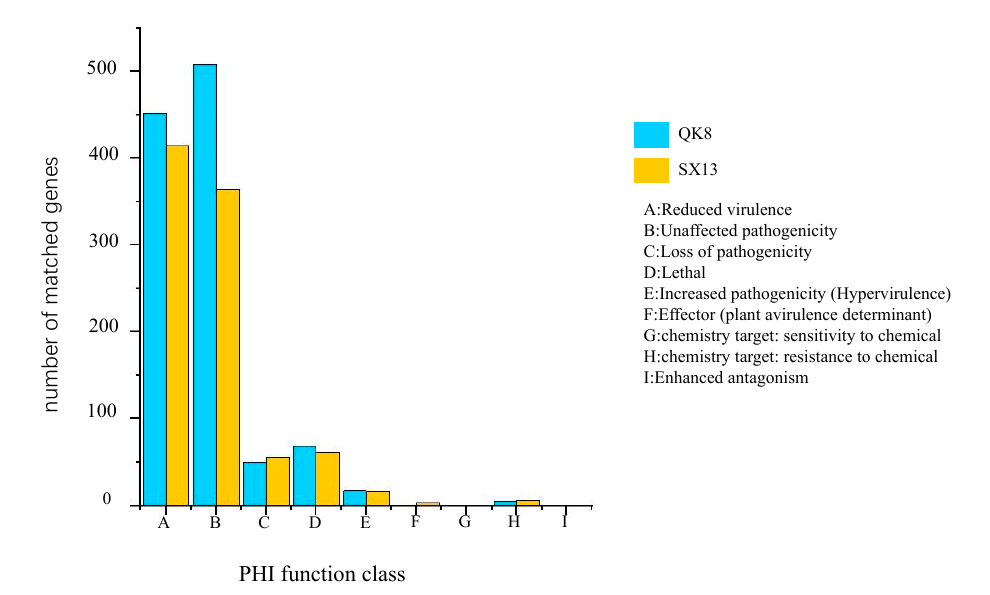
Figure 7. PHI functional annotation of strains QK8 and SX13.